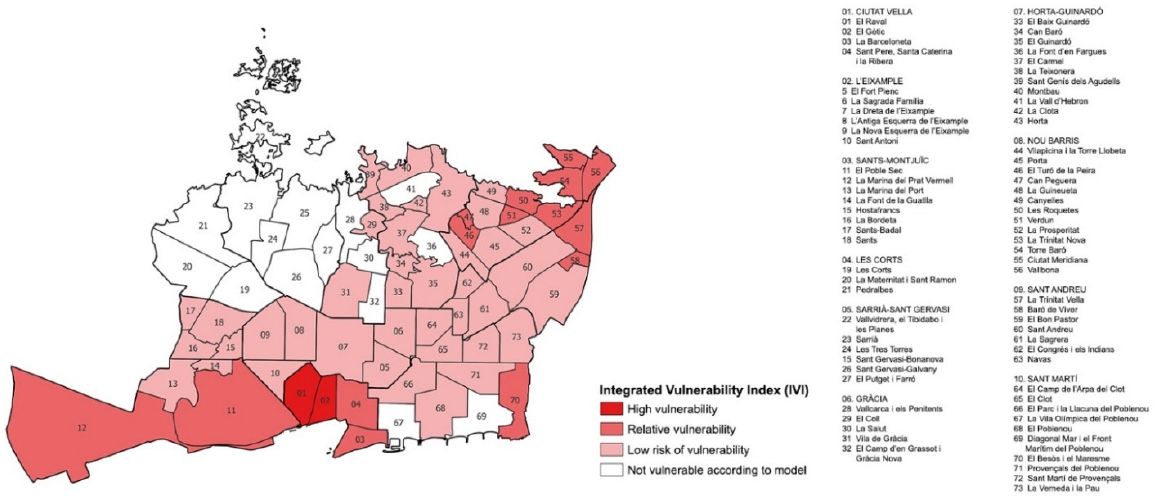
Figure 2. Result of applying the integrated vulnerability index (IVI) to 73 neighbourhoods of the city of Barcelona. Prepared by the authors.